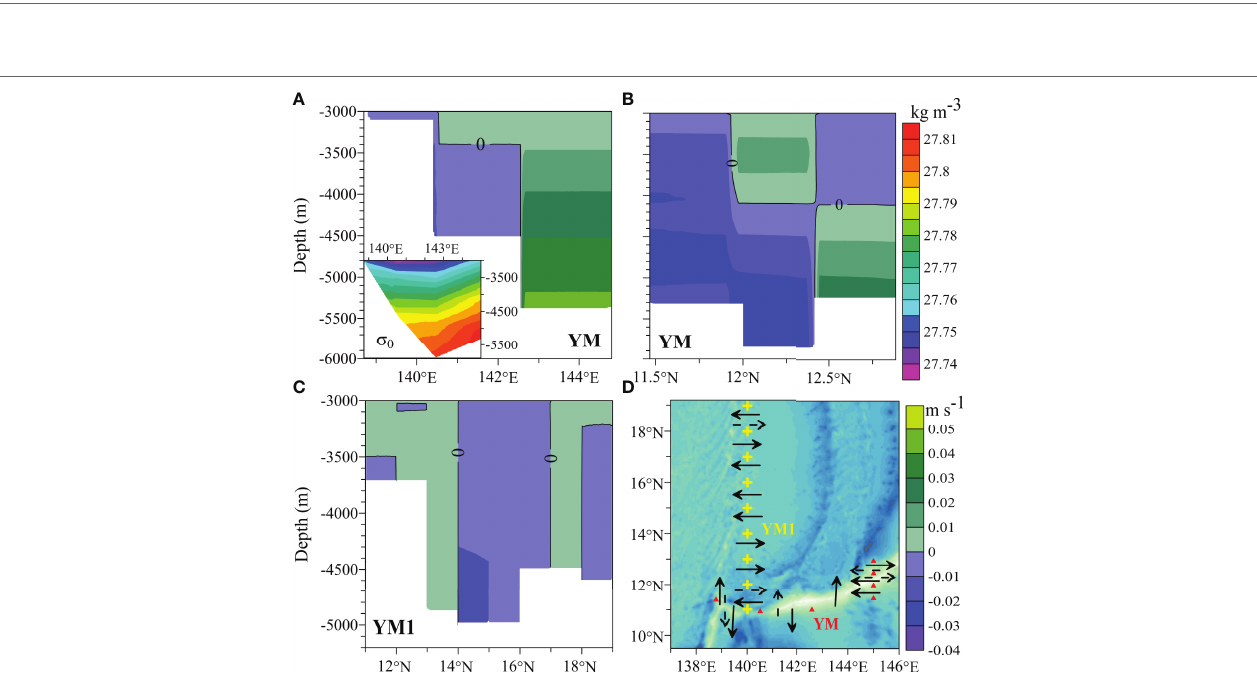
FIGURE 4 | Meridional flows at section Y1 (A) , zonal flows at sections WM1 (B) and WC1 (C) across the southern Yap Trench, and a schematic of water transportation at these sections (D) . Potential density σ 0 are presented. For zonal flows, a positive value represents the eastward direction. A brown arrow line denotes lower flows shown in (A, B) , and a blue line denotes upper flows shown in (A) . Symbols (black + ) are observation sites of section WM1 across the trench.